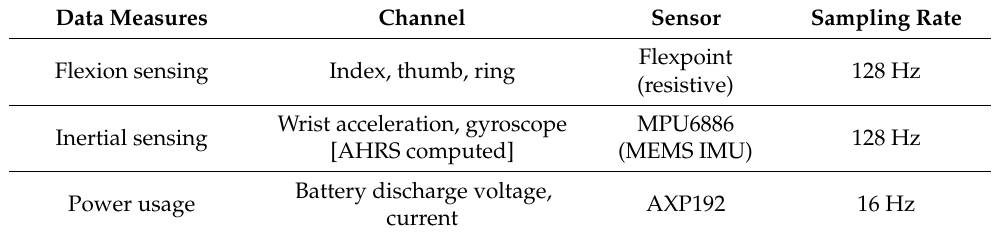
Table 2. Data measures associated with iTex gloves.